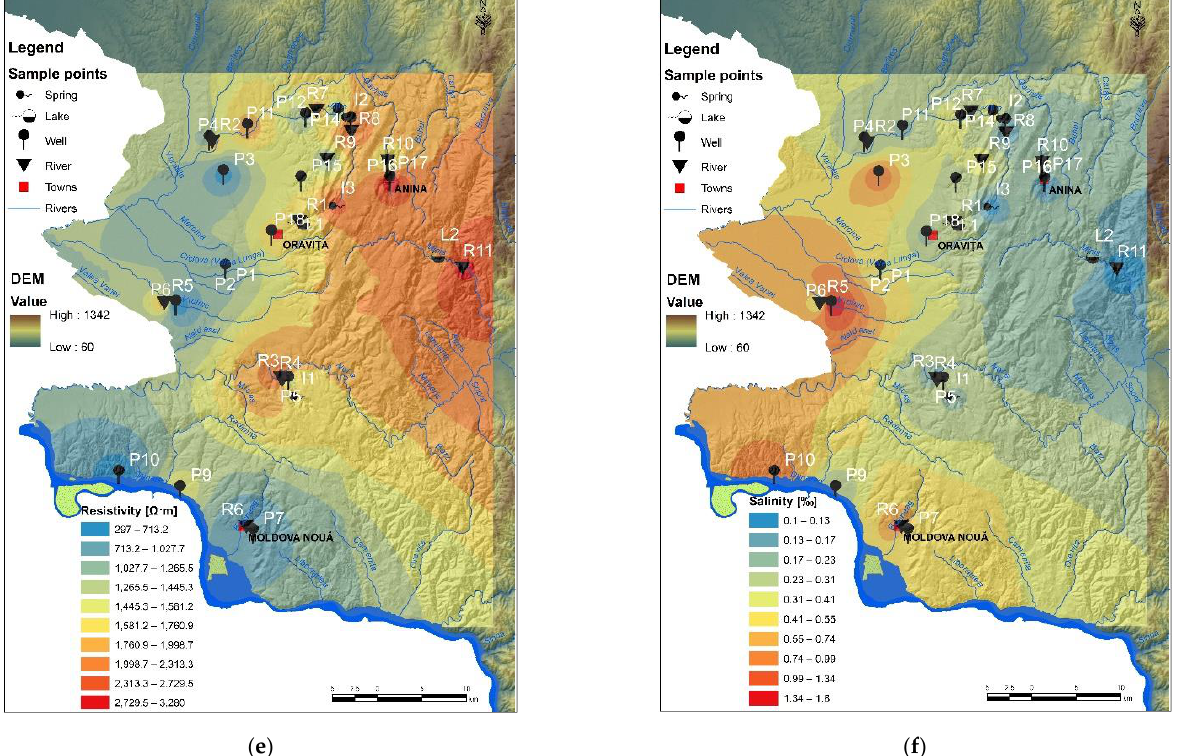
Figure 2. Physicochemical indicators of water quality: ( a ) pH; ( b ) electrical conductivity; ( c ) dissolved oxygen; ( d ) oxidation-reduction potential (ORP); ( e ) resistivity; and ( f ) salinity.